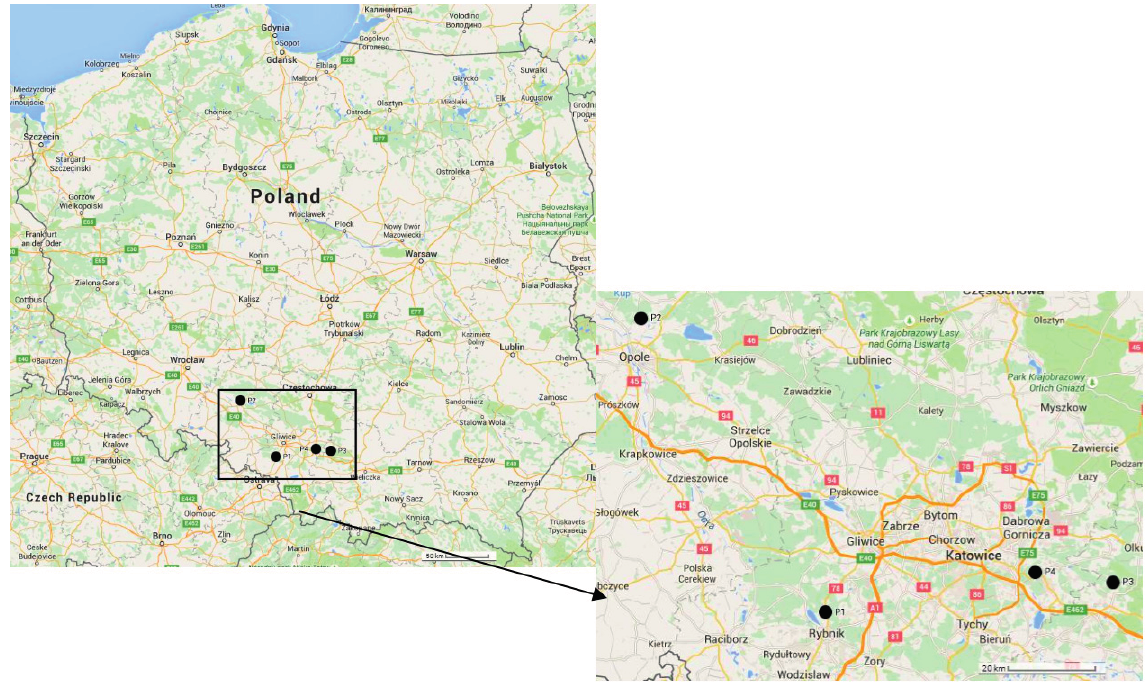
Figure 1. Localization of sampling sites in Southern Poland (Map data: © 2015 Google,